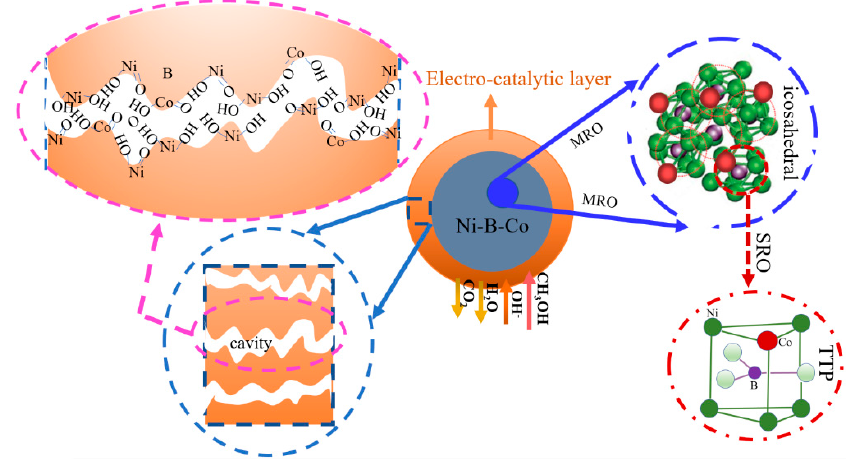
Figure 7. An electrocatalytic layer on the amorphous Ni-B-Co nanoparticles during the methanol